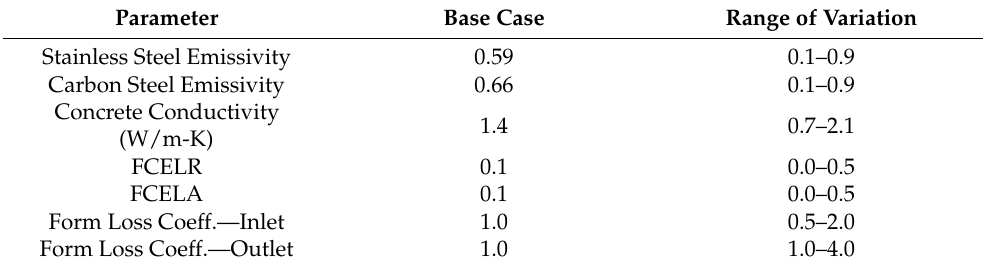
Table 4. The input